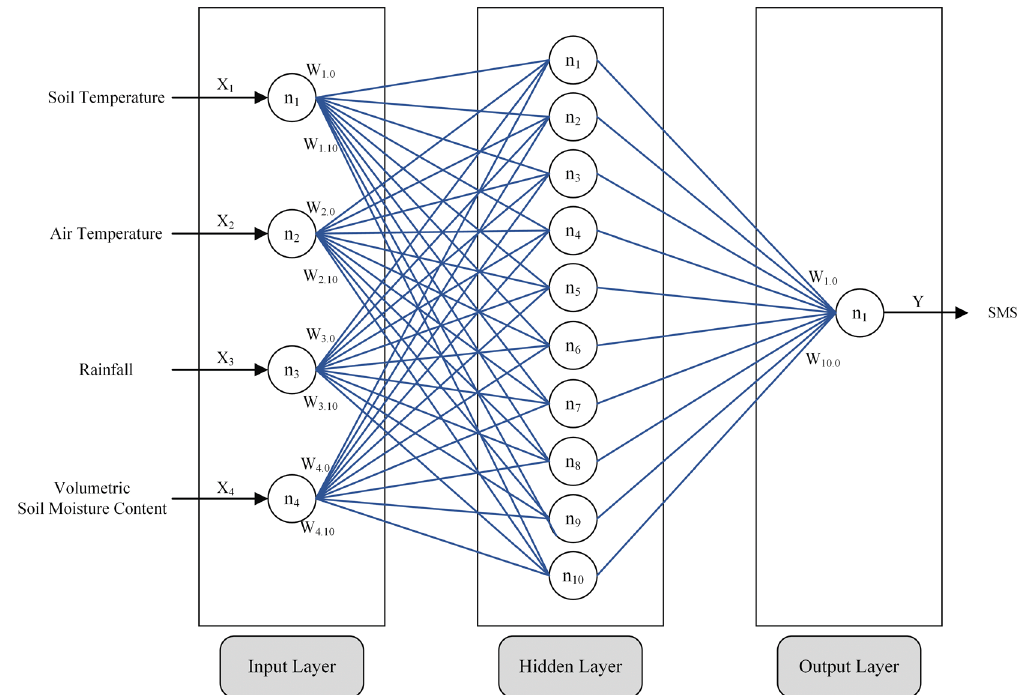
Figure 6. Schematic representation of the predictive ANN-BR